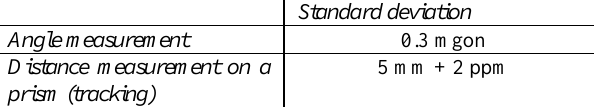
Table 1. Measuring accuracy of the Leica TPS1201.